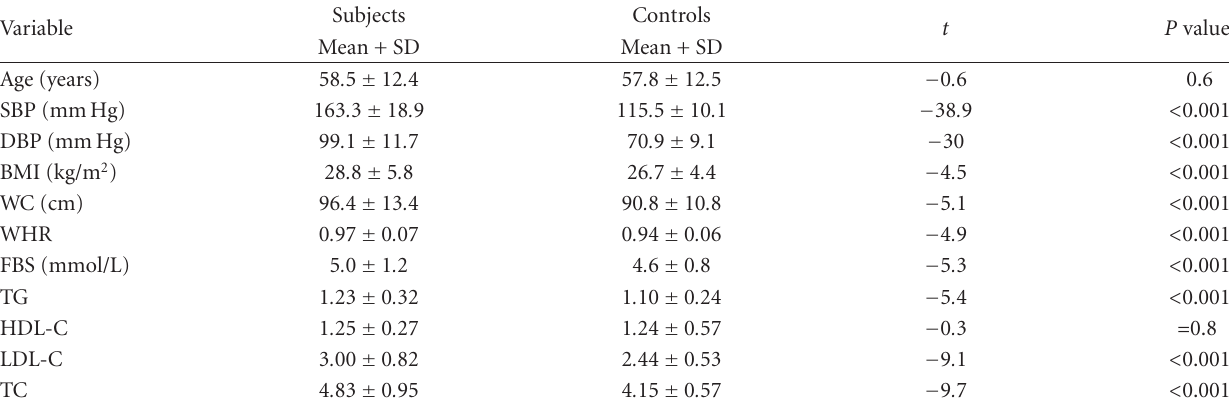
Table 1: Shows the demographic, clinical, and biochemical profile of the subjects and controls. Variable